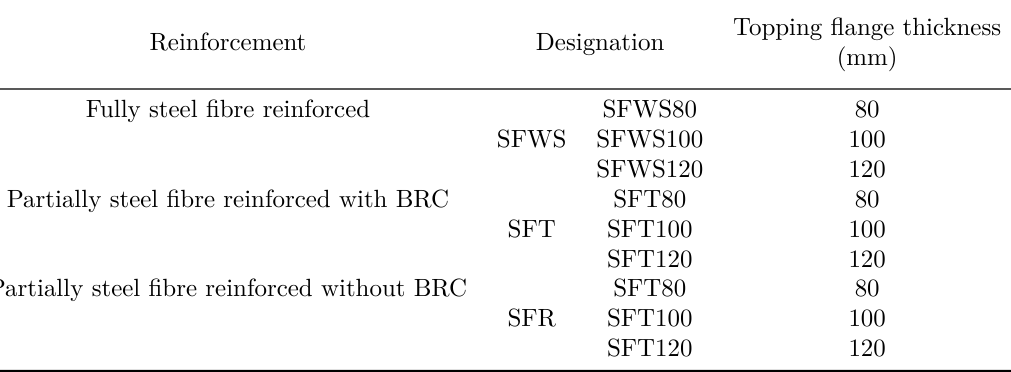
Table 2. Steel fibre properties.